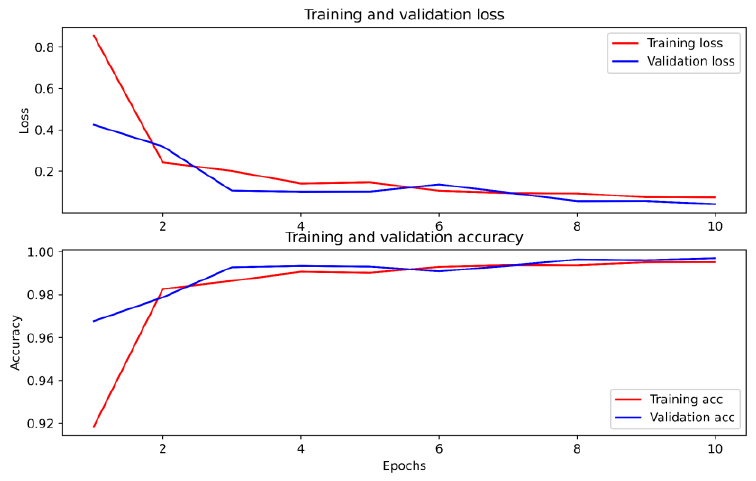
Figure 9. Accuracy and loss curves. Table 6. Selected features and